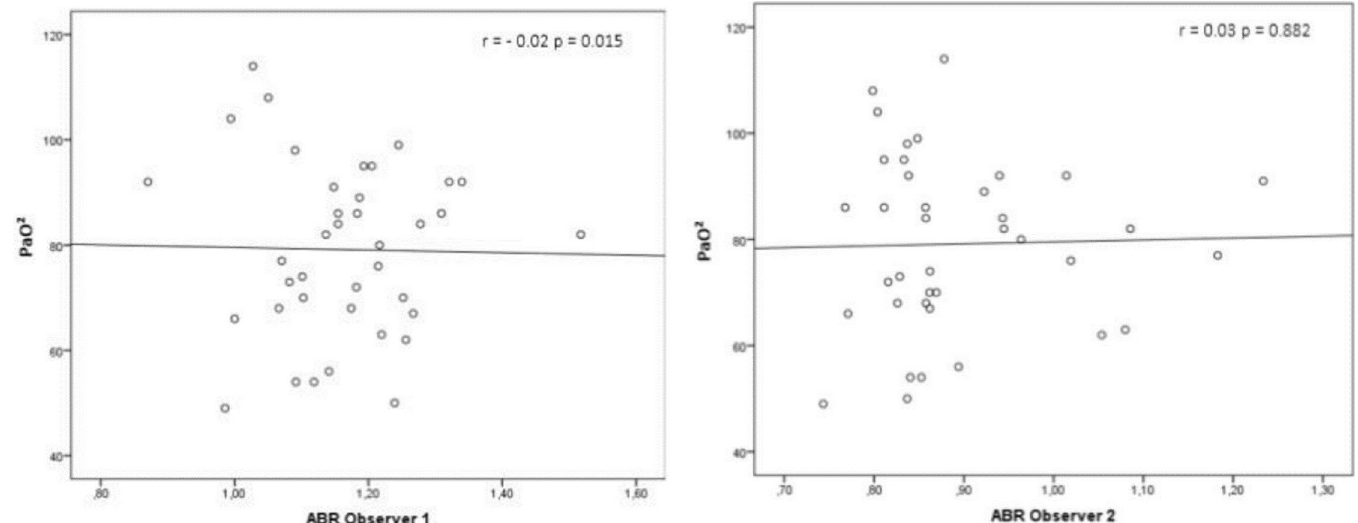
Fig 3. Linear correlation between PaO 2 and ABR. Linear correlation between partial pressure of oxygen (PaO 2 ) and the artery-to-bronchus ratio (ABR) for observer 1 and 2.